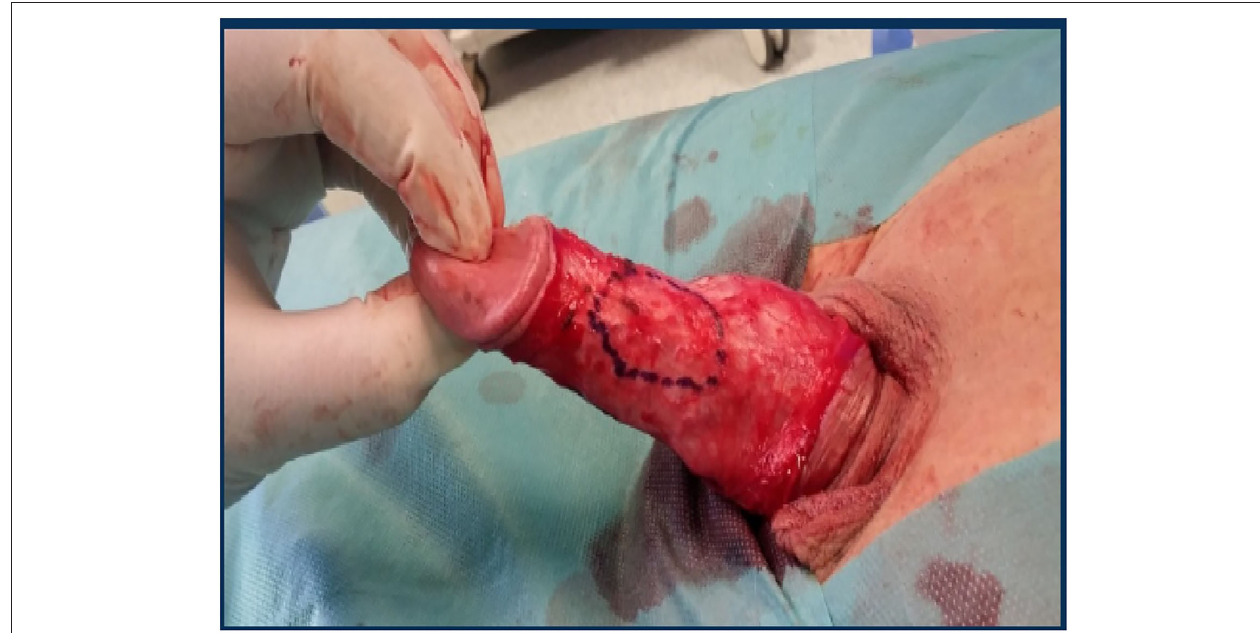
FIGURE 1 | Plate delimitation.